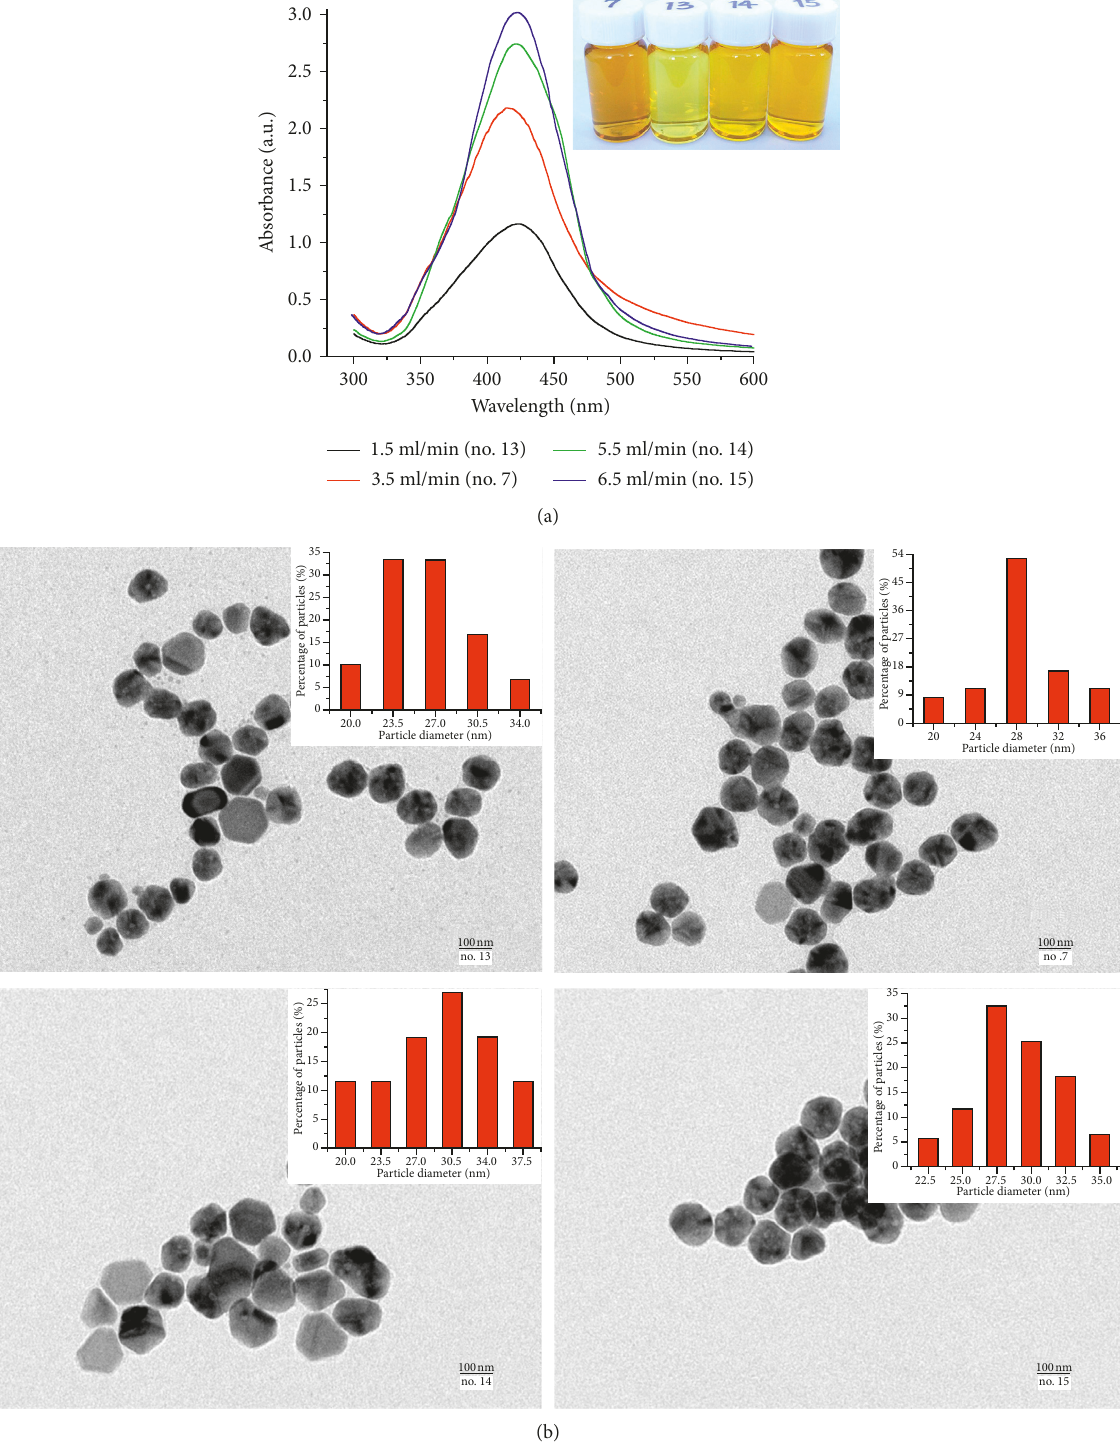
Figure 6: UV-Vis absorption spectra (a) and TEM images (b) of four groups of AgNPs synthesized under different inlet flow